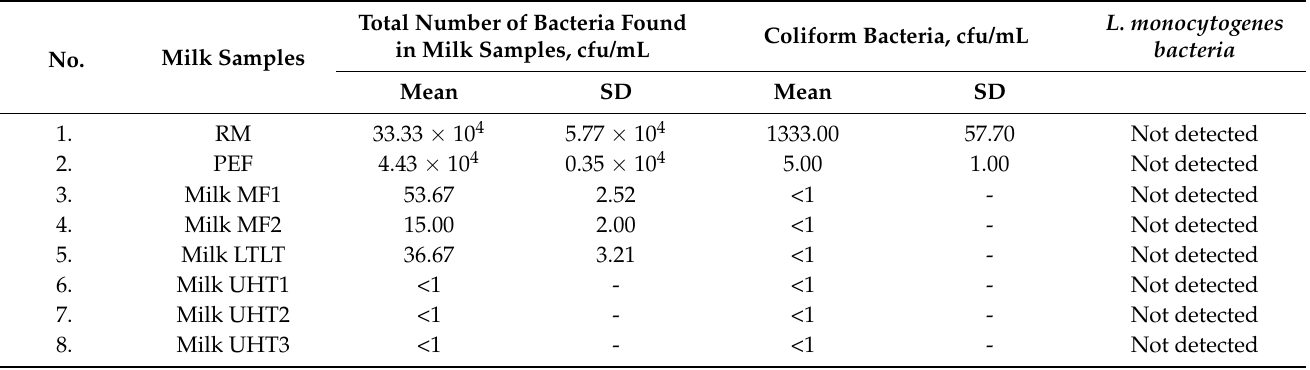
Figure 3. E. coli DH5 α inactivation dependence on PEF strength, after 24 h of incubation in agar plates at 37 °C. The abscissa shows the voltage used during the experiment; the ordination axis presents the average number of colony count for each voltage. C—Control (raw milk). Control and PEF-treated suspensions were diluted with pasteurized (UHT) milk at ratio of 1:100. Different lowercase letters indicate significant differences between the samples ( p < 0.05). Table 1. Bacterial count in milk samples treated with different pasteurization techniques: RM—raw milk (control); PEF— pulsed electric field; LTLT—low-temperature long-time; UHT1—ultra-high temperature; UHT2—ultra-high temperature; UHT3—ultra-high temperature, MF1—microfiltration; MF2—microfiltration after 24 h of incubation in agar plates at 37 ◦ C. Note: results are expressed as mean ± standard deviation